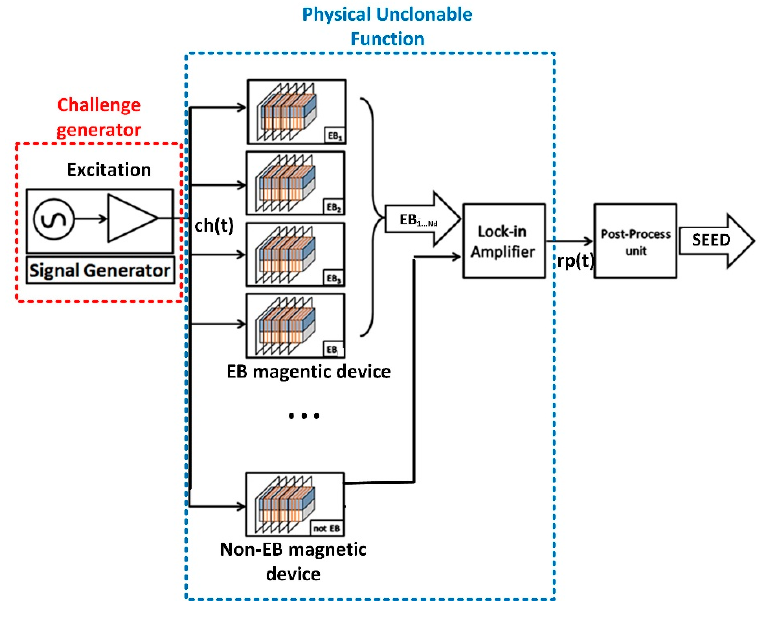
Figure 4. PUF schematics.